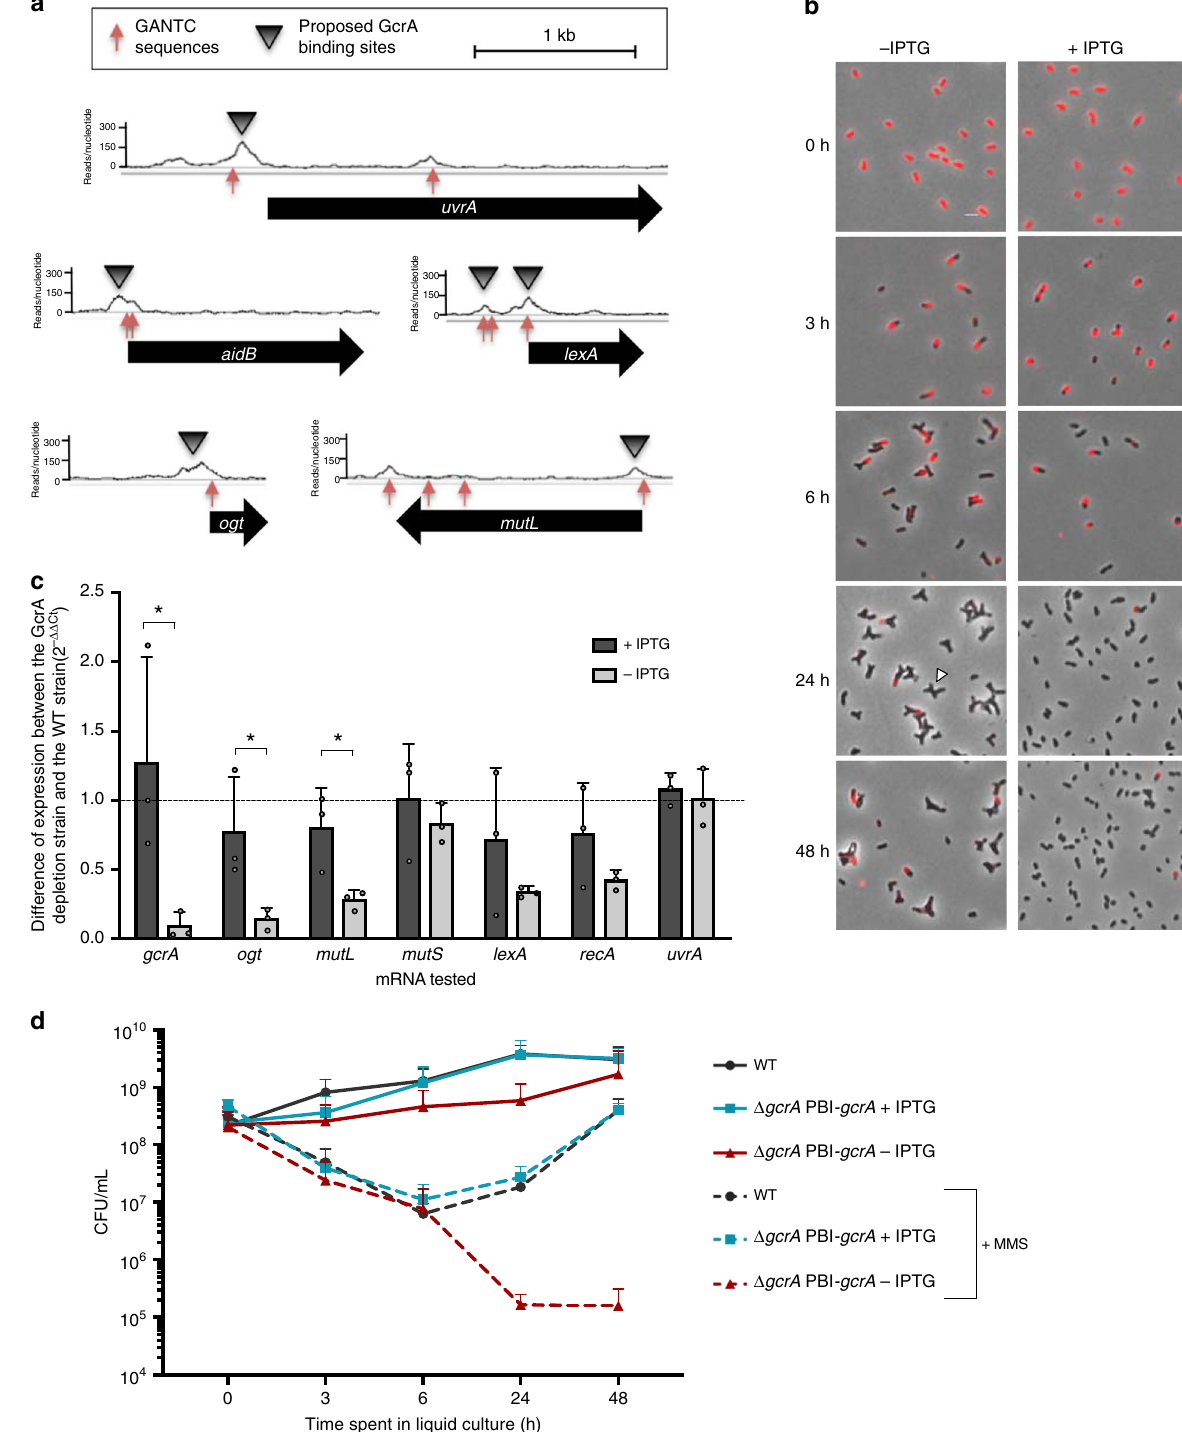
(Supplementary Fig. 8a). RT-qPCR was performed on DNA repair genes after culturing B. abortus Δ gcrA pBI- gcrA in the presence or absence of IPTG. This con fi rmed that GcrA regulates the expression of ogt and mutL (Fig. 6c). Of note, the induction of lexA still occurred after MMS exposure in the absence of GcrA (Supplementary Fig. 8b), indicating that the activation of the SOS response under exogenous stress is regulated through a GcrA- independent